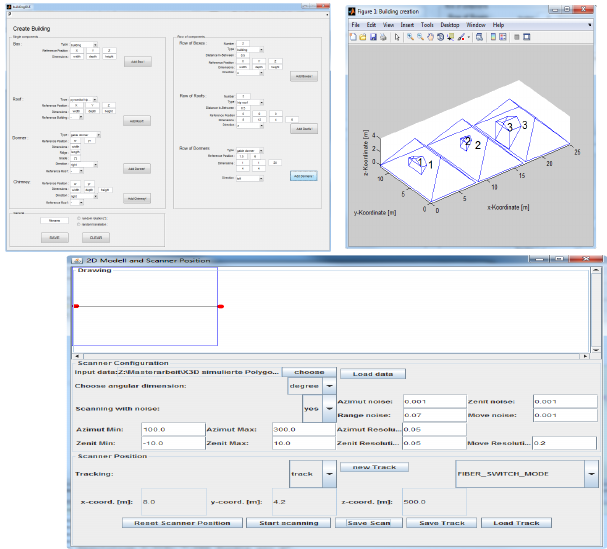
Figure 2. Front-end of the simulation toolbox. Building simulator (top) and laser scanning simulator